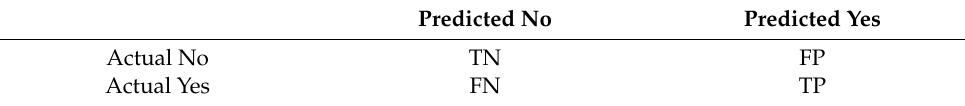
Table 2. Confusion matrix.